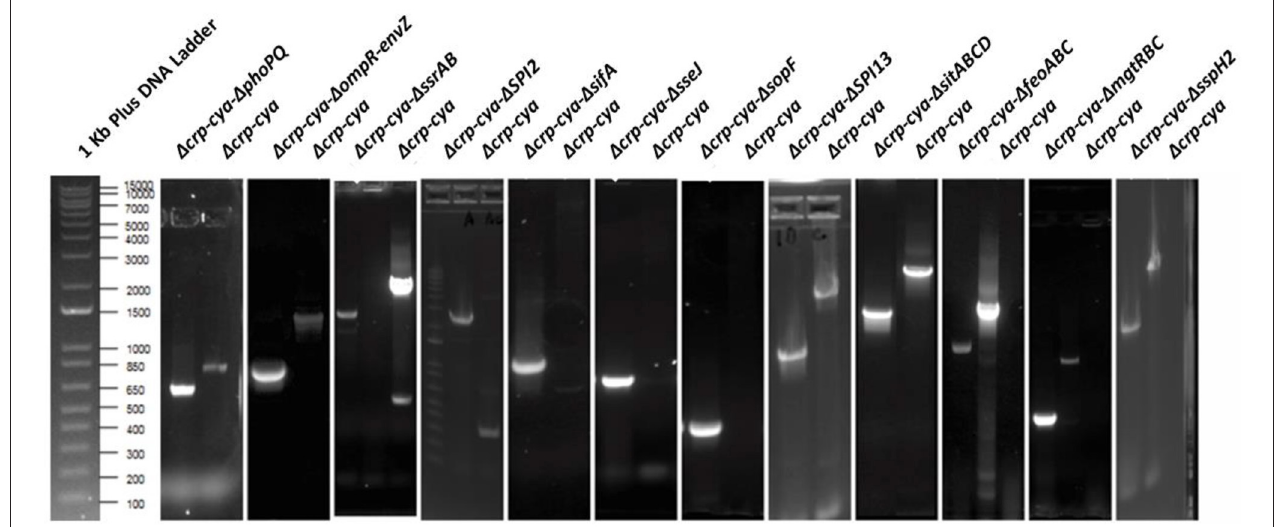
FIGURE 3 | Agarose gel electrophoresis images of confirmation of gene deletions in S. Typhimurium UK1 1 crp - cya derivatives. PCR amplification was performed to confirm the deletions. For 1 crp - cya - 1 phoPQ, 1 crp - cya - 1 ompR-envZ , 1 crp - cya - 1 ssrAB , 1 crp - cya - 1 SPI13 , 1 crp - cya - 1 sitABCD , 1 crp - cya - 1 feoABC ,